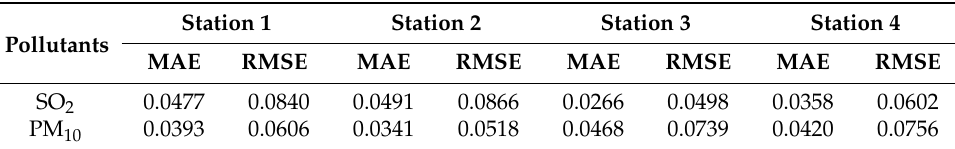
Table 12. Forecast accuracy of SVM of SO 2 and PM 10 .